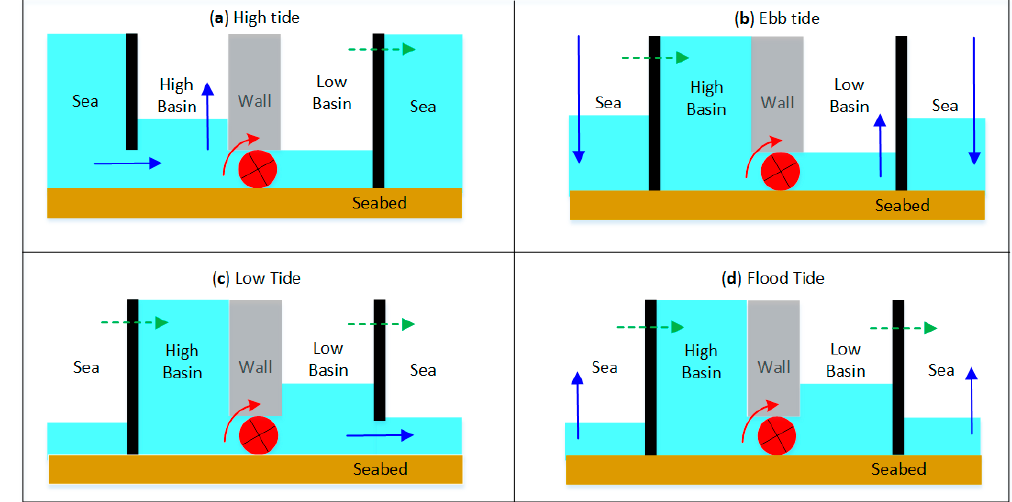
Figure 14. Tidal energy generation mechanism for the system shown in Figure 13a. The continuous blue arrows indicate the direction of gravity-driven water flow, the dotted green arrows indicate the direction of pumped water flow. The turbines generate power at all stages. Adapted from [26]. ( a ) generation at high tide; ( b ) generation at ebb tide; ( c ) generation at low tide; ( d ) generation at flood tide